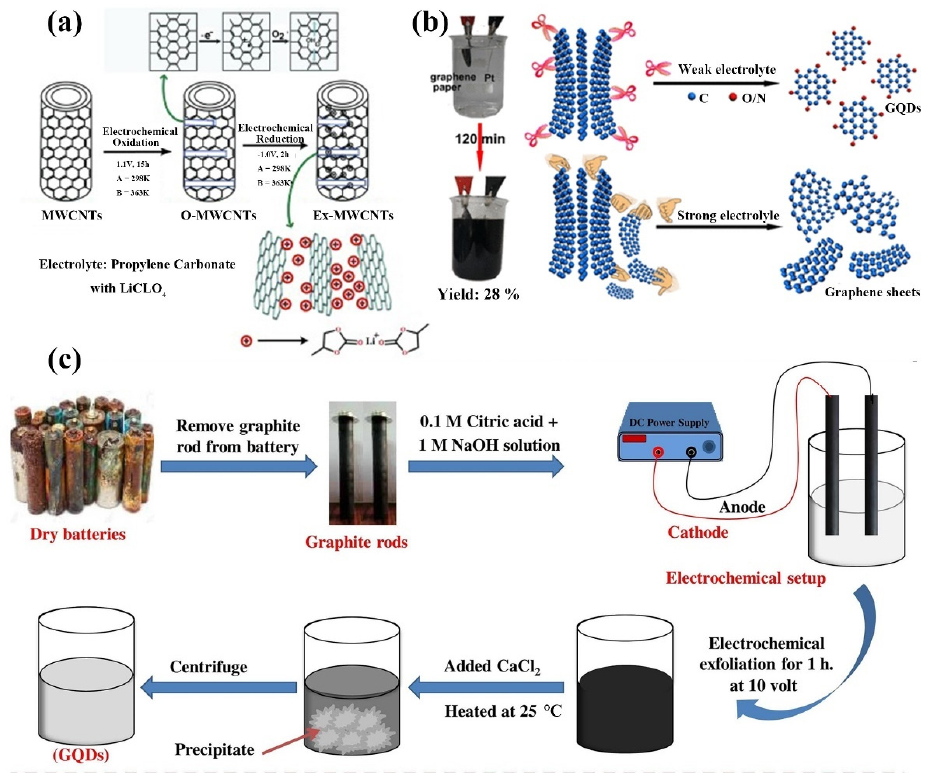
Figure 7. ( a ) Green luminescent GQDs with diameters of 3.5 and 8.2 ( ± 0.3) nm, respectively, were prepared electrochemically at 90 °C using LiClO 4 , while similar particles with diameters of 23 (±2) nm were obtained at 30 °C under the same conditions. Reprinted with permission from Ref. [102].